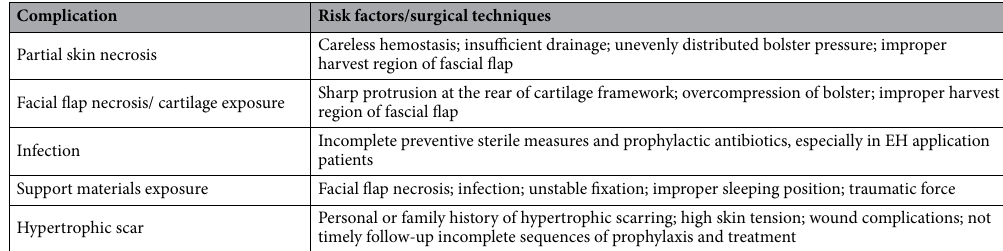
Table 5. Factors/surgical techniques associated with risks of